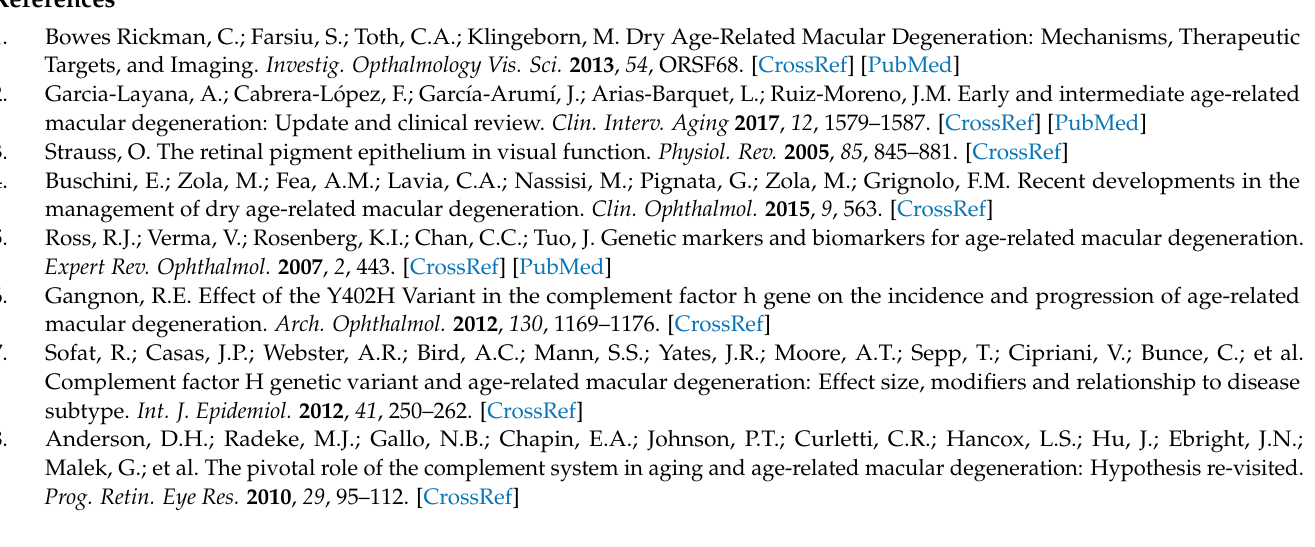
cytosol; Table S1: Donor characteristics and clinical information–haRPE tissue; Table S2: Donor characteristics and clinical information–haRPE cell cultures; Table S3: Antibodies used in this study; Table S4: Primers for real-time PCR